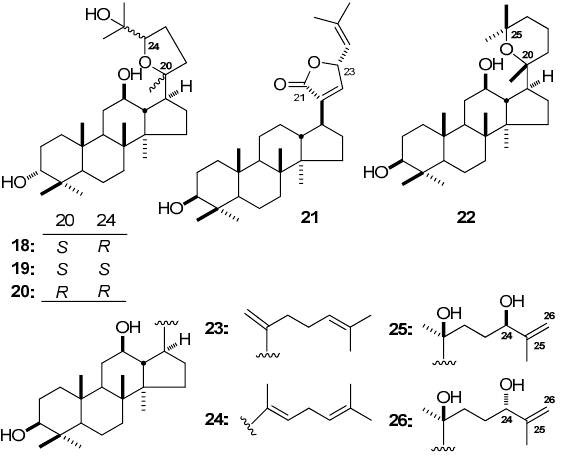
Figure 3. The structure of compounds 18 – 26 .